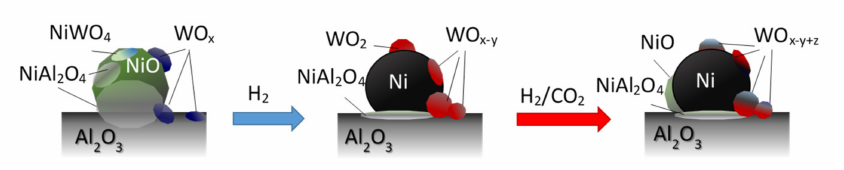
Figure 11. Schematic illustration of oxide phase transformations in alumina-supported, tungsten- promoted nickel catalysts under reduction and CO 2 methanation reaction